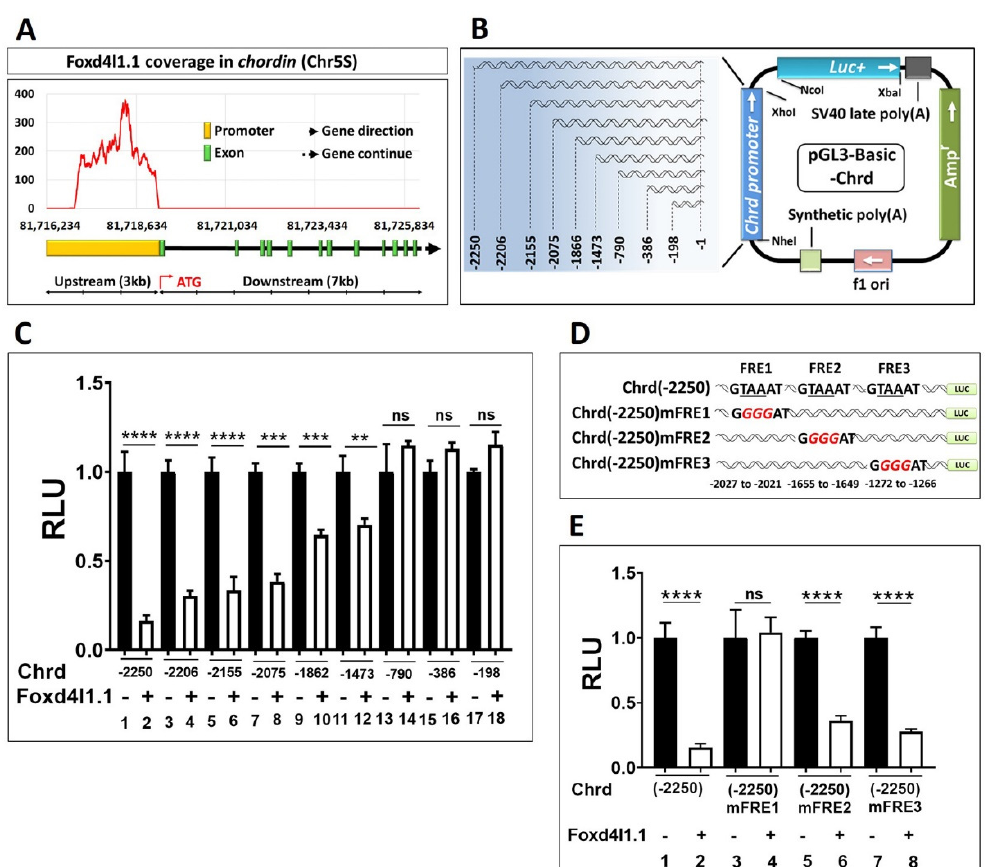
Figure 3. Chrd promoter contains FRE1: ( A ) ChIP-sequencing coverage plot of Foxd4l1.1 within the chrd promoter region; ( B ) schematic representation of the serially deleted promoter constructs of chrd promoter. The numbering of promoter constructs (or cis -acting response elements) is given from the translational start site (TLS); ( C ) relative promoter activities of serially deleted promoter constructs of chrd(-2250) with or without Foxd4l1.1; ( D ) systemic representation of mutated FRE1, FRE2, and ARE2 (targeted sequences; underlined, italic, red color) within the region of − 2250 bps chrd promoter construct; ( E ) relative luciferase activity for chrd(-2250), chrd(-2250)mFRE1, chrd(-2250)mFRE2, and chrd(-2250)mFRE3 with or without Foxd4l1.1. ** p ≤ 0.01, *** p ≤ 0.001, and **** p ≤ 0.0001, n.s. denotes non-significant values.